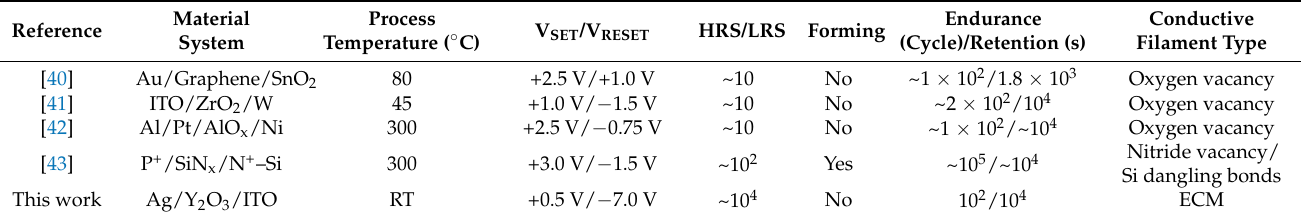
Figure 8. ( a – c ) Representative endurance properties; ( d – f ) retention properties of the ITO/Y 2 O 3 /Ag RRAM devices obtained under different annealing treatments. Table 1. Comparison of the resistive switching characteristics of the low-temperature-processed RRAM devices.